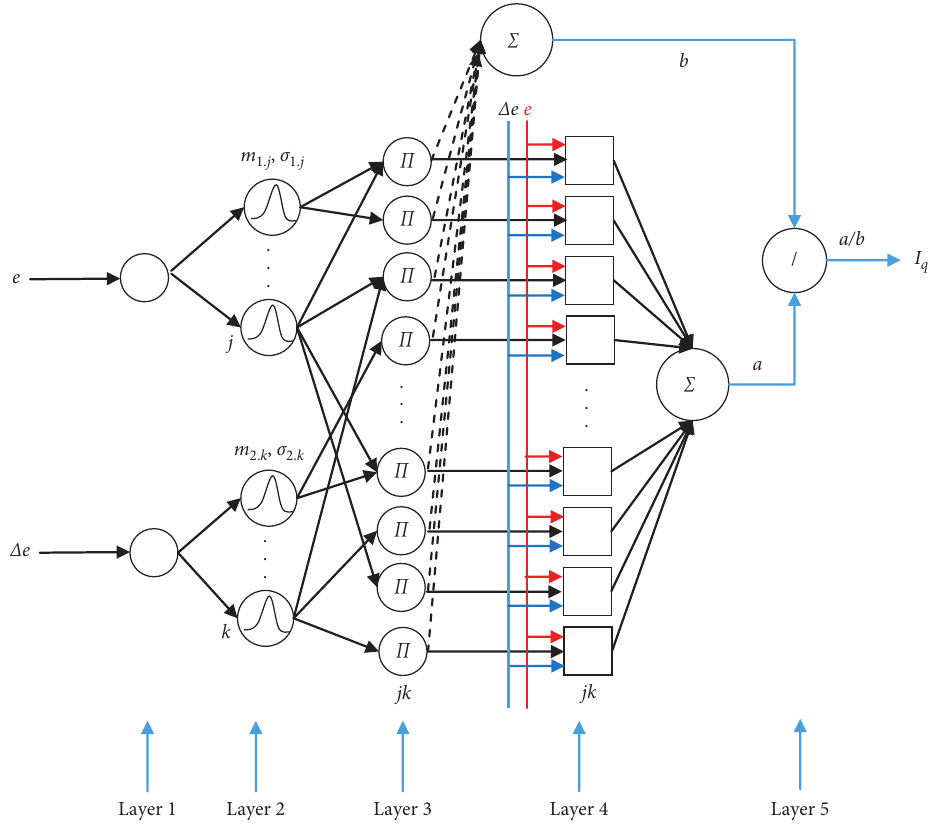
Figure 2: Fuzzy neural network used as